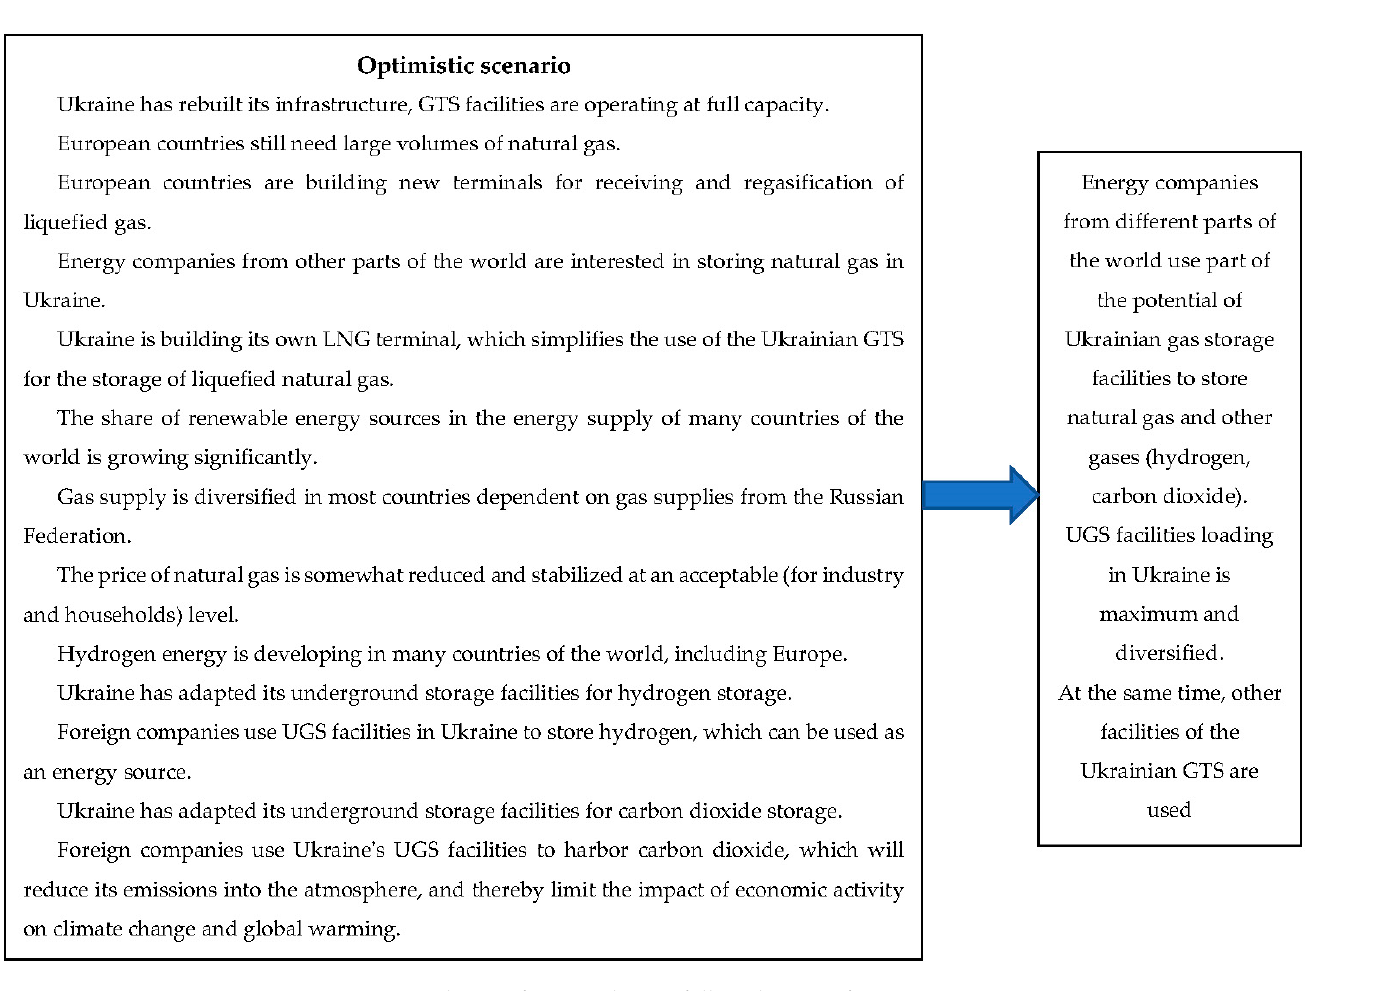
Figure 14. This is a figure. Schemes follow the same